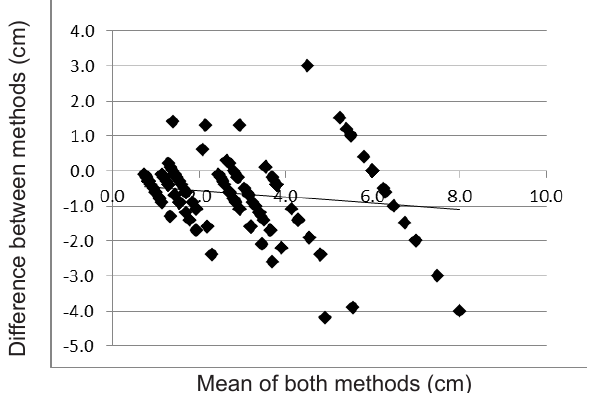
Figure 2. Bland-Altman Plot of data obtained from paired measurements of seven different wound simulations (estimations provided in inches). Correlation R = 0.1625 (p=0.01). Slope =